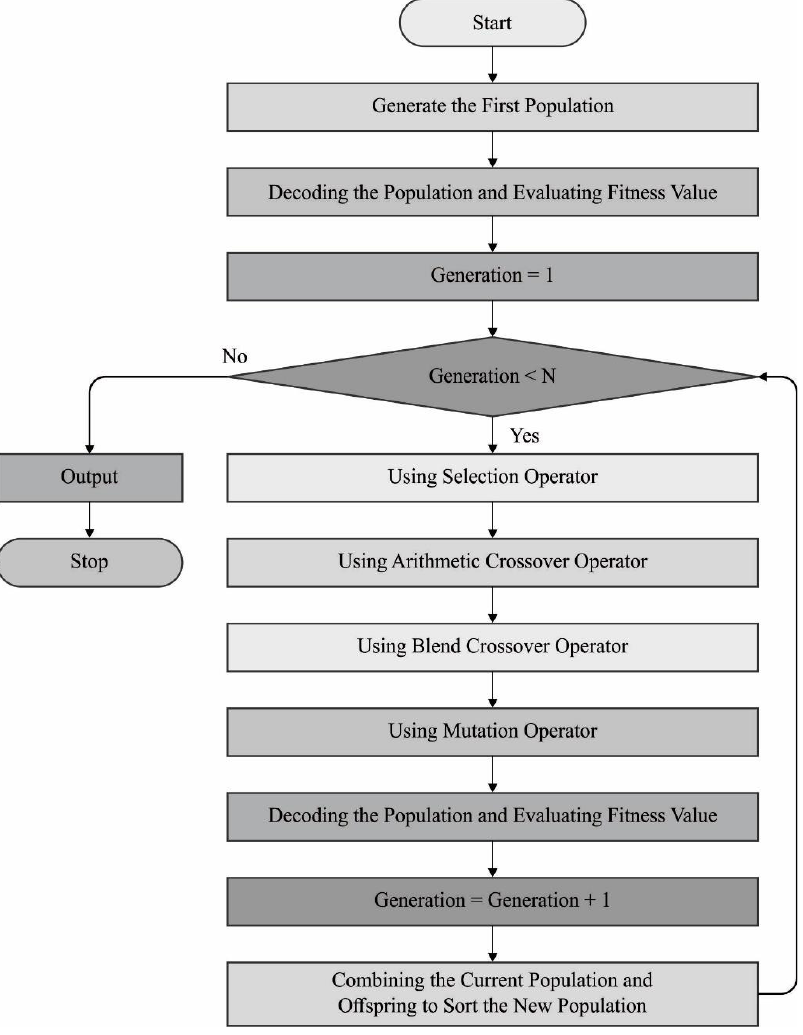
Figure 3. Flowchart of NSGA II Algorithm.